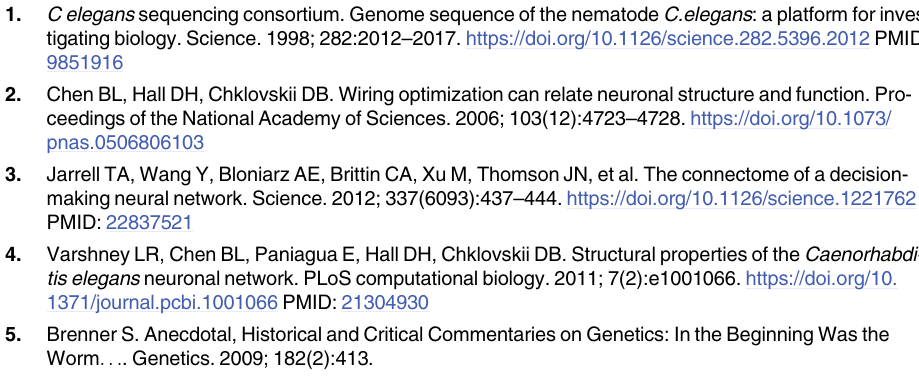
= − 70 mV. B) RMD neuron h (Eq Ca